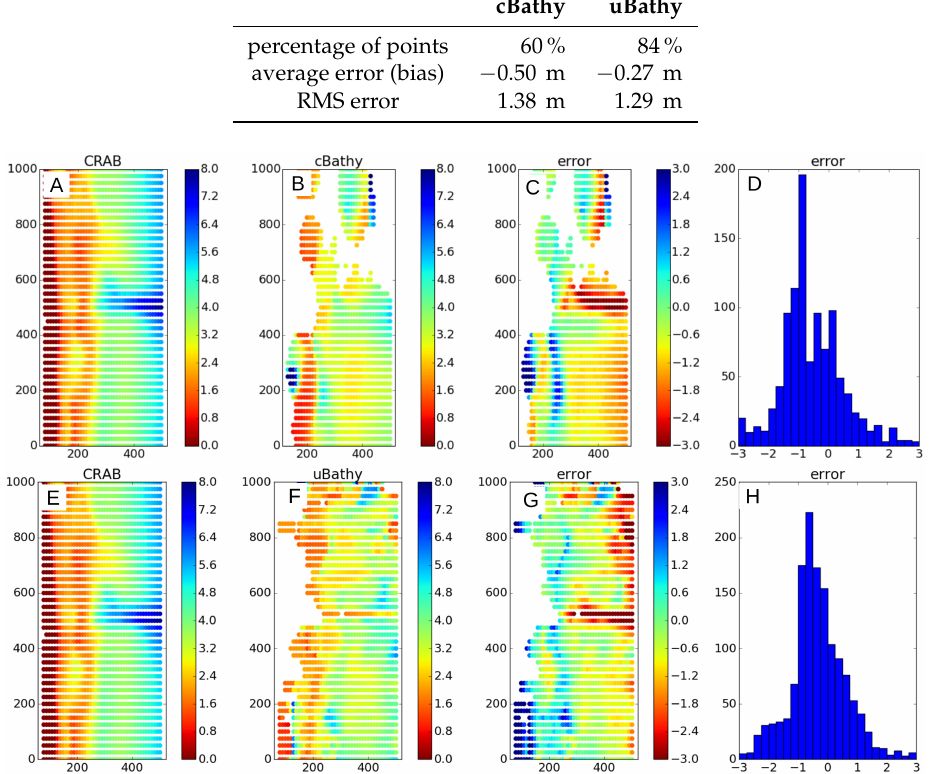
Figure 15. On top (bottom) are results from cBathy (uBathy). From left to right: measured bathymetry with the CRAB ( A , E , in m), inferred bathymetry ( B , F , in m), error of the inferred bathymetry ( C , G , in m), and histogram of the errors for the pixels ( D , H